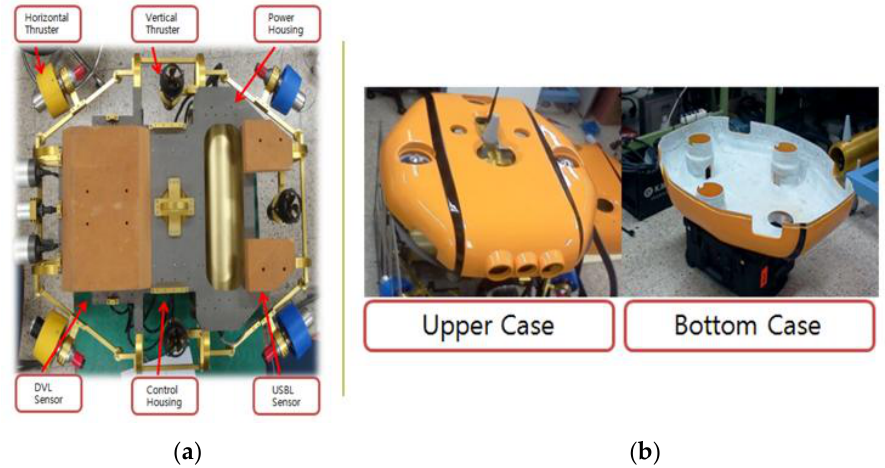
Figure 5. The thruster structure of the UUV: ( a ) internal parts of the UUV; ( b ) Composition of cover.